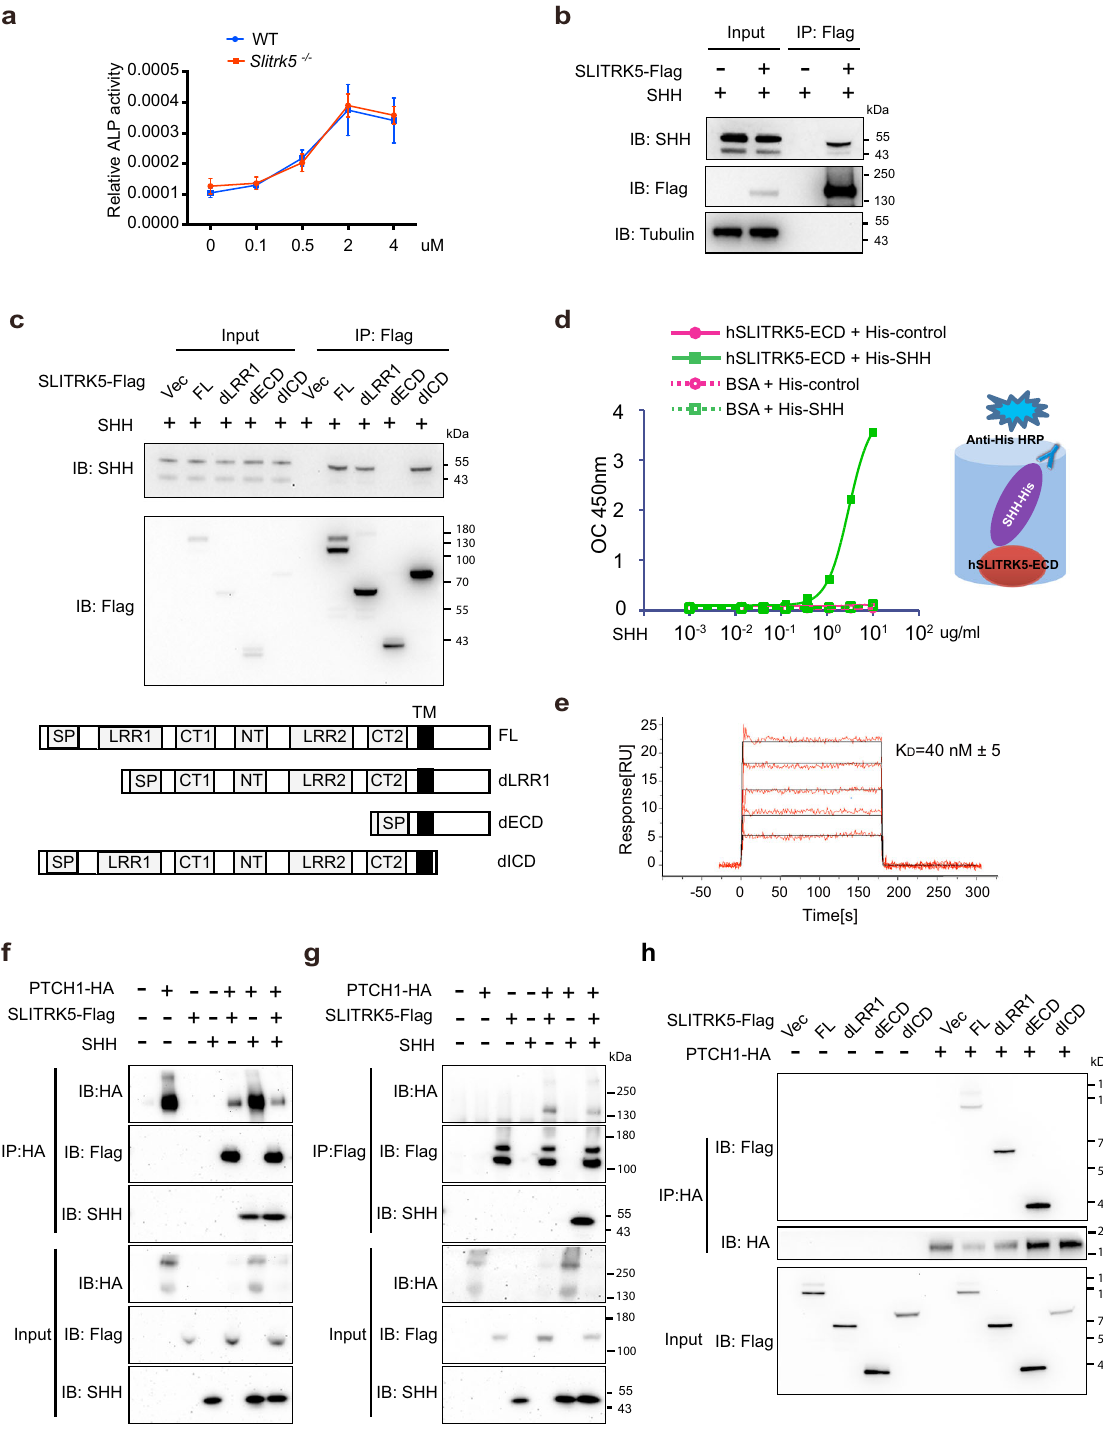
Fig. 3 SLITRK5 interacts with SHH and PTCH1. a Primary osteoblasts from WT and Slitrk5 − / − mice were treated with the indicated doses of Purmorphamine and cultured in osteoblast differentiation medium. ALP activity was measured at day 3 of differentiation. Data are presented as mean ± s.d. n = 6 biologically independent samples. b Co-immunoprecipitation of Flag-SLITRK5 and SHH in HEK293T cells. Data are representative of four independent experiments. c Co-immunoprecipitation of SHH and Flag-tagged SLITRK5 truncation mutants in HEK293T cells. Data are representative of three independent experiments. d ELISA assay showing the interaction of hSLITRK5-ECD and SHH. e Surface Plasmon Resonance analysis of the binding of SHH to SLITRK5. SHH was injected over a SLITRK5 surface at 125, 62.5, 31.25, 15.625, and 7.8125 nM. f , g Co-immunoprecipitation of Flag-SLITRK5 and HA- PTCH1 in HEK293T cells with BSA or SHH treatment. Data are representative of two independent experiments. h Co-immunoprecipitation of PTCH1 and Flag-tagged SLITRK5 truncation mutants in HEK293T cells. Data are representative of three independent